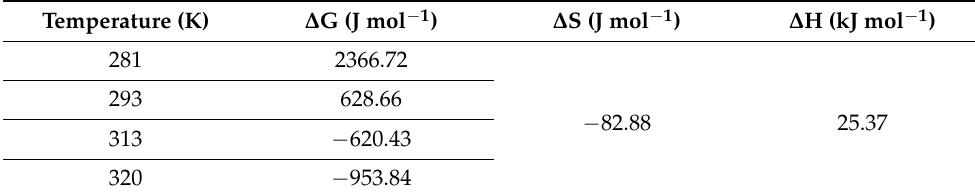
Figure 7. ( A ) Effects of temperature on CPX removal and ( B ) the van’t Hoff graph for the system. Table 4. Thermodynamic parameters of CPX adsorption in PSB.